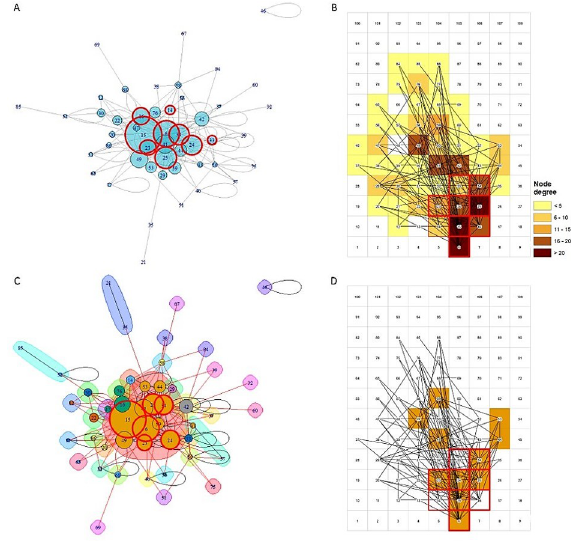
Fig 4. Spatial network configuration of stable sexual partnerships. A) Eigenvalue estimations for each node. Nodes with highest eigenvalues are centered close to the nodes with more links. Circles delineated in red indicate the nodes located within the HIV cluster. B) Map illustrating the node degree of each pixel. Nodes with high degree are illustrated in dark brown, whereas nodes with low degree are illustrated in yellow. C) Illustrates the different node communities identified in the network. Circles delineated by red illustrate the nodes located within the geographical HIV high-risk area. D) Map illustrating the location of the cells included in the main node community of the network (brown cells). The numbers in all figures represent the labels of each node in the